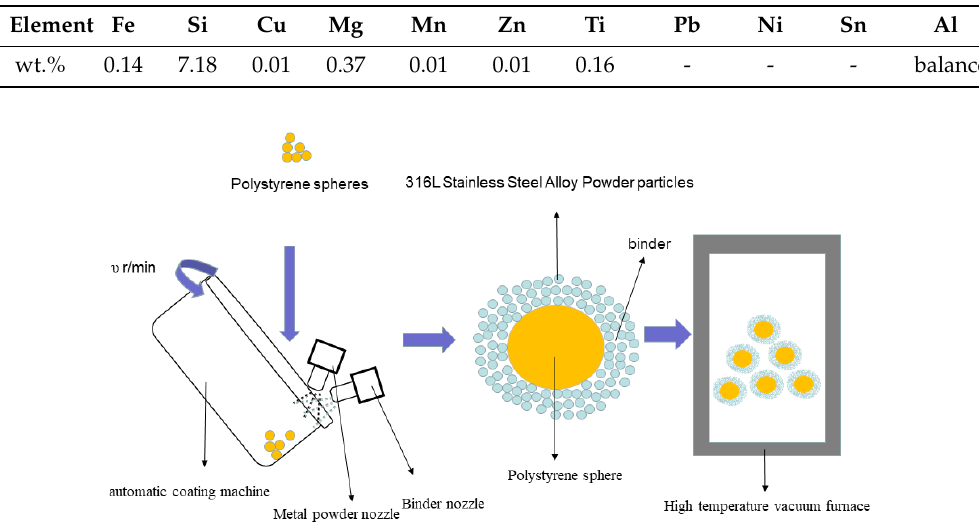
Figure 1. Schematic diagram of the prepared process of metal hollow spheres (MHSs).